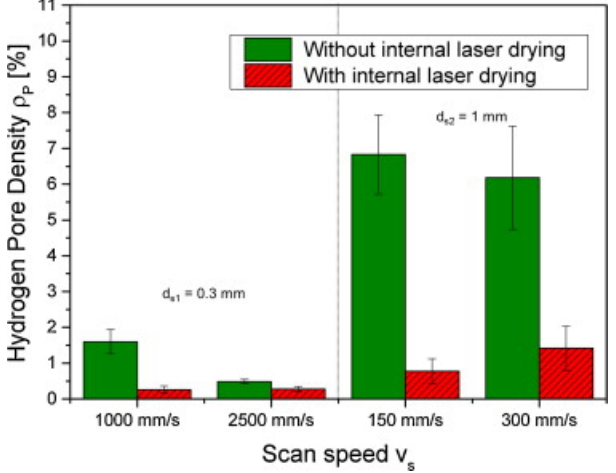
Figure 34. Laser scan rate dependence of the hydrogen pore density observed in AlSi10Mg samples processed by SLM [88]. Copyright 2015. Adapted with permission from Elsevier Science Ltd. under